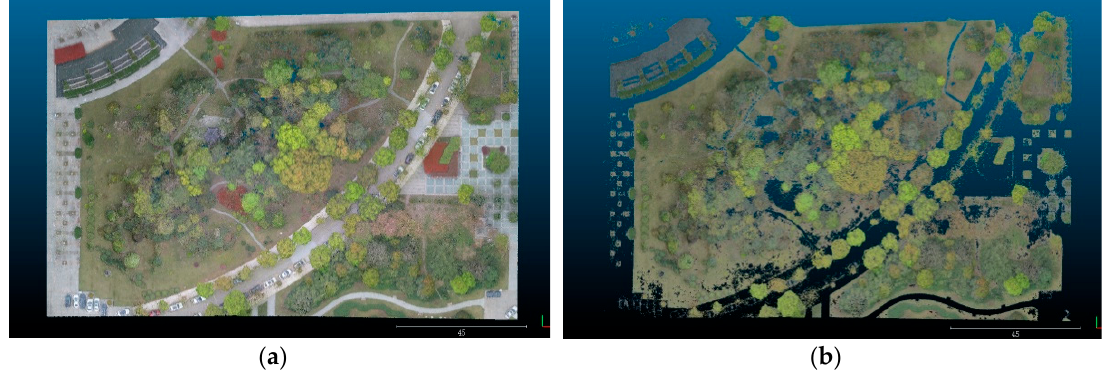
Figure 2. Result of green vegetation discrimination by ExG index: ( a ) 3D point cloud model of the study area before extraction by ExG index and ( b ) 3D point cloud model of the study area after extraction by ExG index. Non-green points have been deleted from the 3D model.